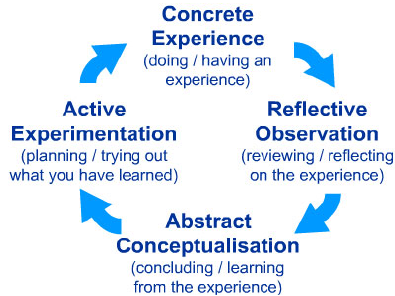
Figure 1-Kolbe’s learning cycle